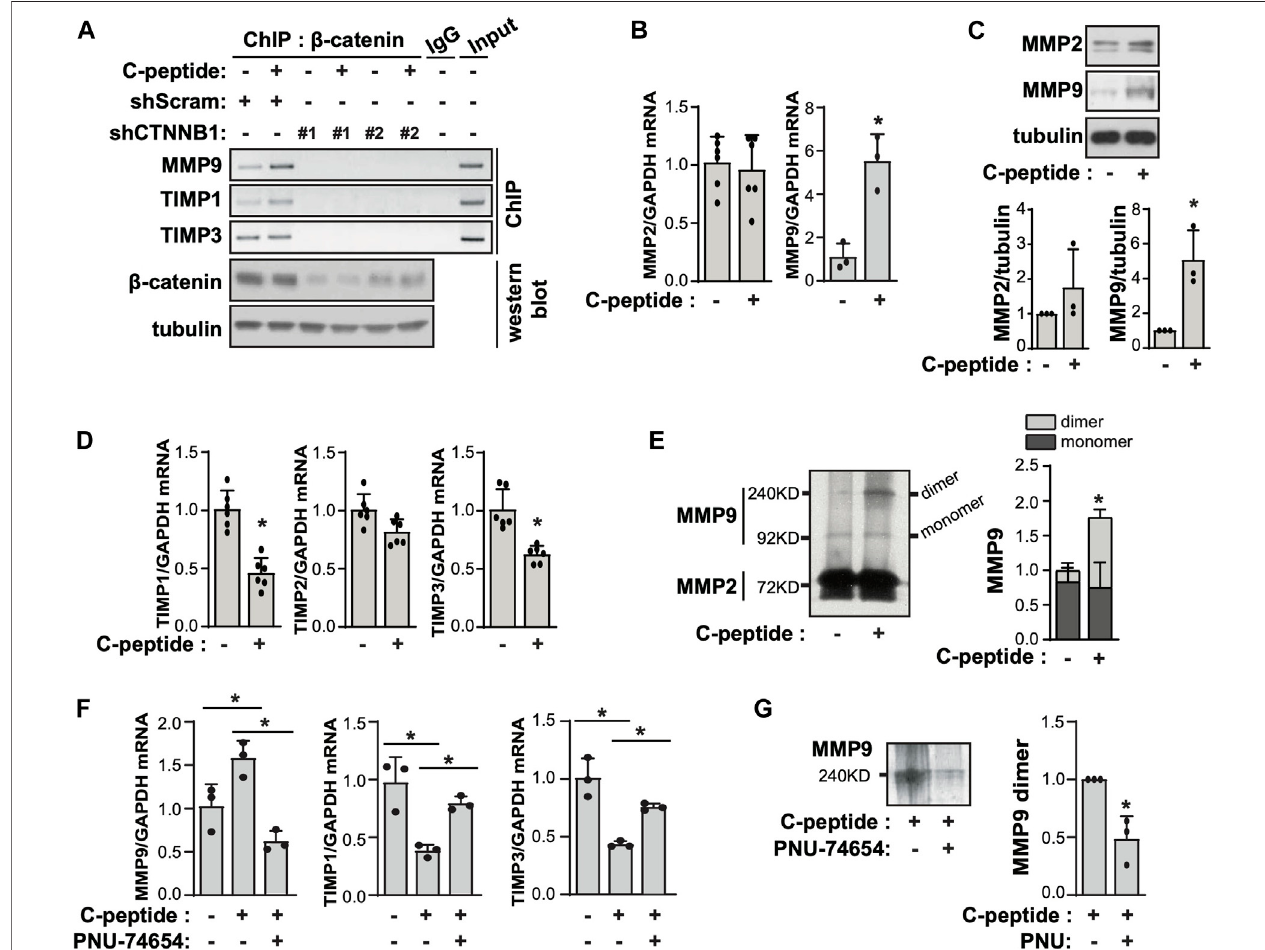
FIGURE 4 | C-peptide increases the expression of MMP9/TIMP1/TIMP3 and the activity of MMP9 in a β -catenin-dependent manner in undecidualized human endometrialstromalcells. (A) Theundecidualizedhumanendometrialstromalcells(UnD-ESCs)weretransducedusingshorthairpinRNAs(shRNAs)forscrambleand β - catenin and selected for 5 days with 1.5 μ M puromycin. Then, cells were serum-starved for 48 h and treated with 50 nM C-peptide for 24 h. UnD-ESCs were lysed and subjectedtochromatinimmunoprecipitation.Theknockdownof β -cateninwascon fi rmedusingwesternblot. (B) UnD-ESCswereserum-starvedfor48 handthen treated with 50 nM C-peptide for 24 h. The cell lysates were analyzed using qRT-PCRfor MMP2, MMP9, and GAPDH. (C) UnD-ESCs were treated as described in (B) , lysed, and then subjected to western blot analysis. (D) UnD-ESCs were treated as described in (B) , and subjected to qRT-PCR for TIMP1, TIMP2, TIMP3, and GAPDH (E) UnD-ESCs were serum-starved for 48 h and then incubated with or without 50 nM C-peptide for 24 h. The cell medium was collected and analyzed using gelatin zymography. TherelativeMMP9 activity wascalculatedbymeasuring theintensitiesofMMPsbandusing ImageJsoftware. (F) UnD-ESCswereserum-starvedfor48 h, pretreated with 10 μ M PNU-74654 for 1 h, and then incubated with or without 50 nM C-peptide for 24 h. The cells were lysed and subjected to qRT-PCR analysis for MMP9, TIMP1, TIMP3, and GAPDH. (G) UnD-ESCs were treated as (F) and the cell medium was collected and subjected to gelatin zymography. Asterisks (*) indicate signi fi cant differences ( p < 0.05) when compared to C-peptide untreated UnD-ESCs control or C-peptide treated UnD-ESCs control. shScram, shRNA for Scramble; shCTNNB1, shRNA for β -catenin.